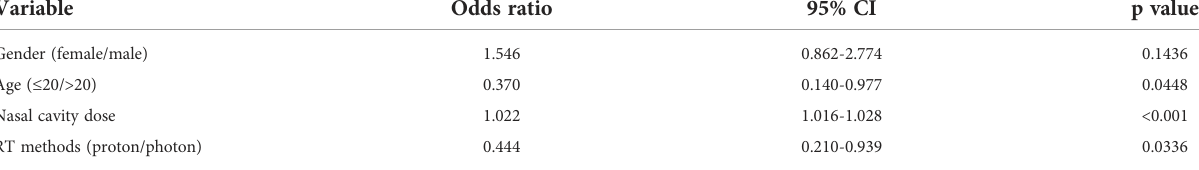
TABLE 6 Multivariate logistic regression analysis of presence of a sense of odor.